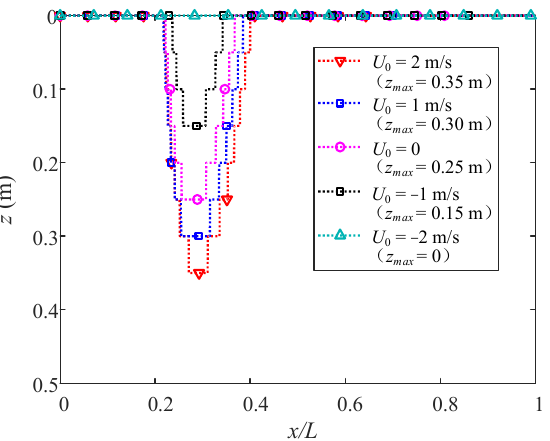
Figure 22. Distributions of maximum liquefaction depth with different current velocities.